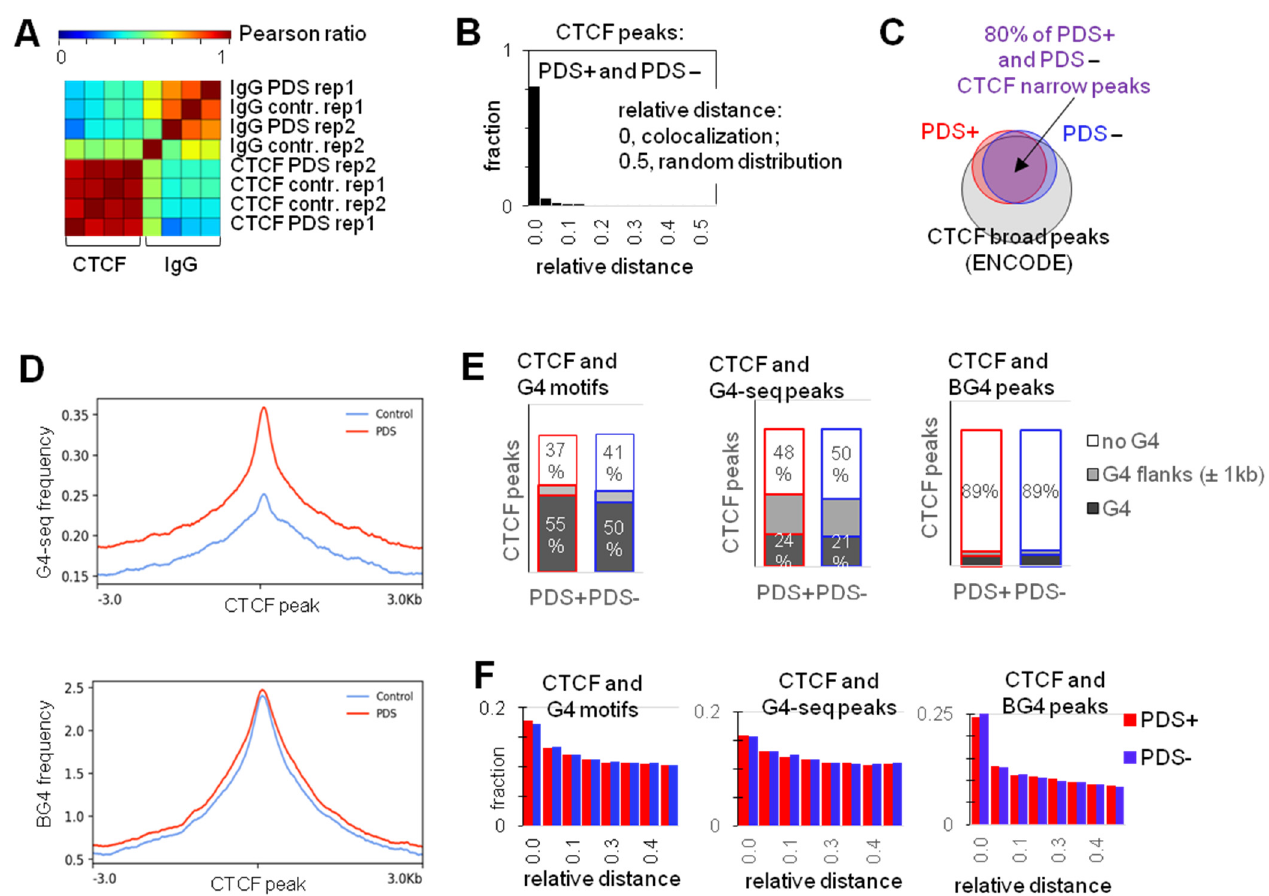
Figure 2. CTCF positioning relative to G4 sites in pyridostatin (PDS)-treated and non-treated cells. ( A ) Summary of the CTCF ChIP-seq data: Pearson correlation between ChIP-seq data sets obtained for PDS-treated (PDS+) and non-treated (PDS − ) K562 cells (two biological repeats). ( B ) Relative distance between PDS+ and PDS- CTCF ChIP-seq peaks. ( C ) Venn diagram summarizing the overlap between PDS+/ − CTCF peaks and the previously reported CTCF ChIP-seq peaks. ( D ) Metaplots illustrating G4-seq and BG4 peak distribution relative to PDS+ or PDS-(control) CTCF peaks. ( E ) Summary of CTCF peak intersections with G4 sites. ( F ) Relative distances between CTCF peaks and G4 sites.